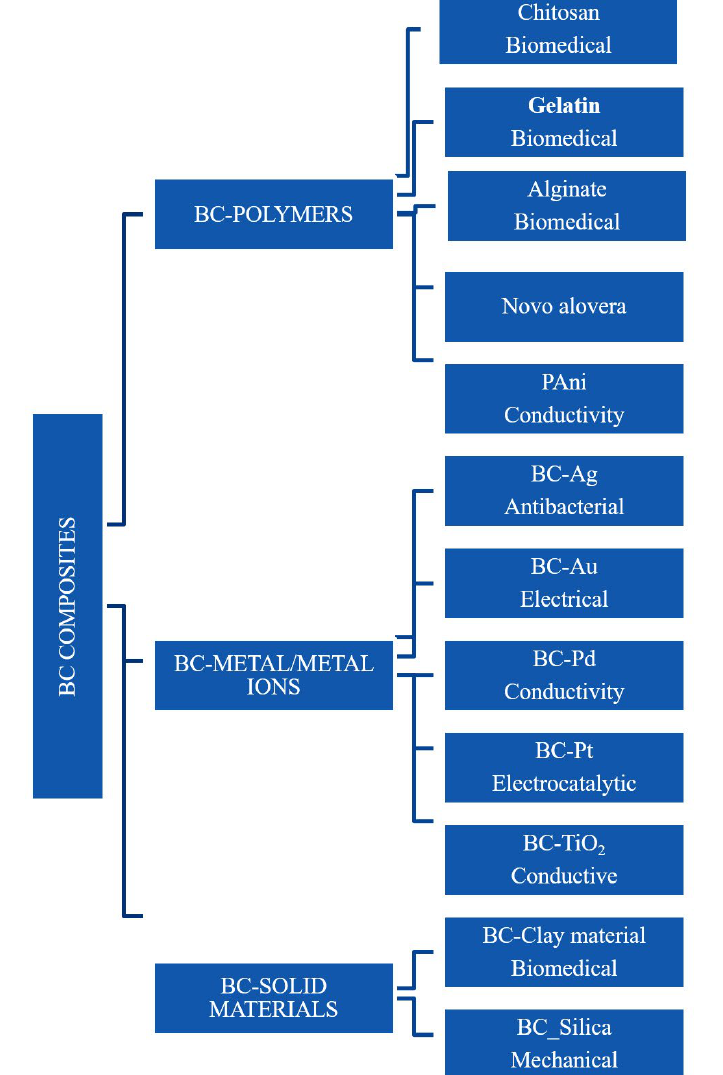
Fig. 2. Classes of BC Composites and their